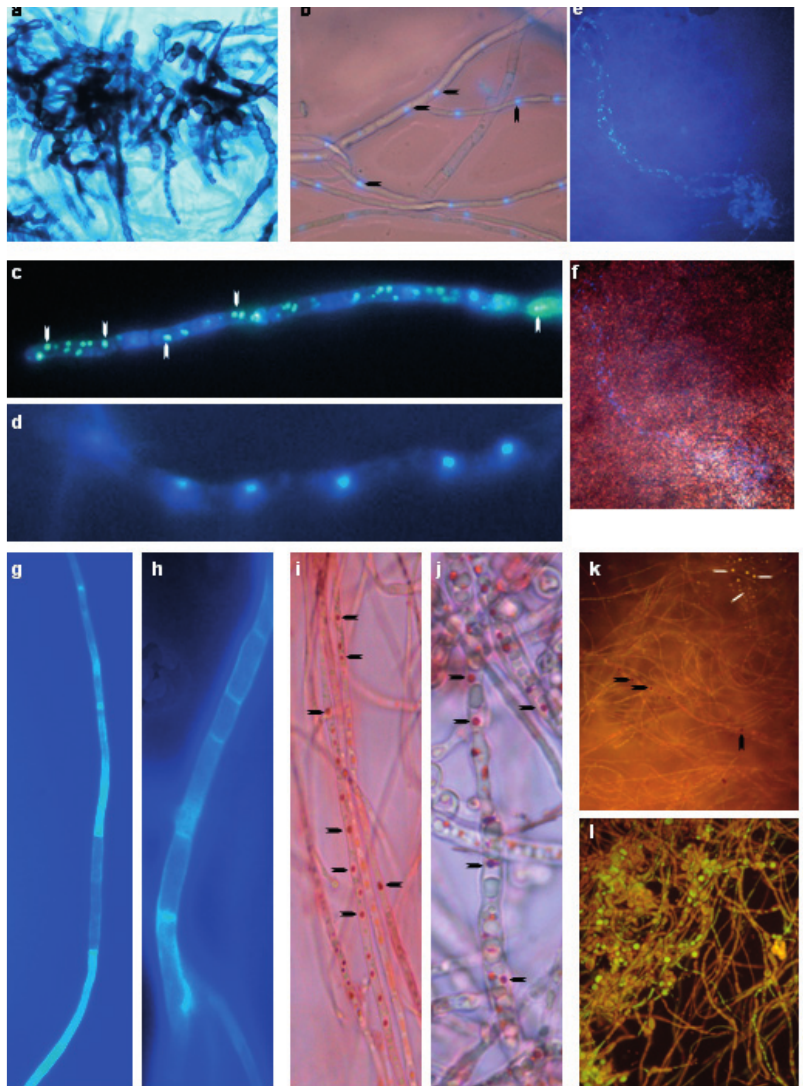
Figure 3. Histochemistry of live hyphae of Seiridium cardinale isolate 167. a. Dark-brown and melanized hyphae. B–F. DaPI staining. one–three separate nuclei (b) and yellow fluorescent cytoplasm (c) characterized hyphal compartments on non-amended medium, whereas nuclei appeared at close range (d), and live hyphae clustered in thin bundles at Ψ = -15MPa (e and f); reference points are indicated by arrowheads. G–H. Calcofluor uptake by s hyphae in control (g) and KCl amended medium (h). I–L. Neutral red staining for vacuoles (black arrowheads) and lipids (white arrowheads) in hyphae grown on control (i and k) and KCl (j and l). Magnification: Figure 3a, b, e, f, k and l, 20 × ; Figure 3c, d, g, h, i and j,